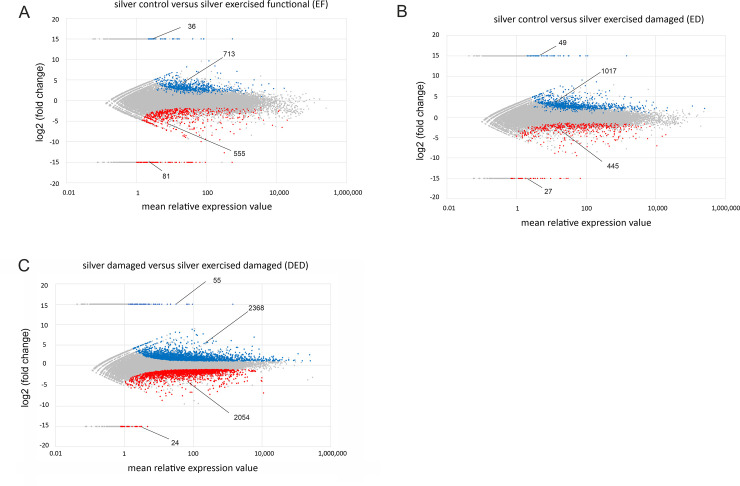
MA-plot of DEGs.(A) MA-plot of DEGs from control swimbladder tissue of unexercised silver eels compared with exercised silver eels, (B) from control silver eel swimbladder tissues and exercised silver eels with damaged swimbladder tissue and (C) from unexercised silver eels with damaged swimbladder compared with exercised eels with damaged swimbladder. Blue and red dots denote up- and down-regulated genes, respectively (pval < 0.01). Grey dots denote non-regulated genes (pval > 0.01). Newly activated or newly deactivated genes were arbitrarily assigned to a log2 (fold change) = 15 or -15, respectively. The value of log2 (fold change) for all genes was analyzed as log2 (exercised/unexercised). Numbers indicate the numbers of DEGs either elevated or reduced in transcription.